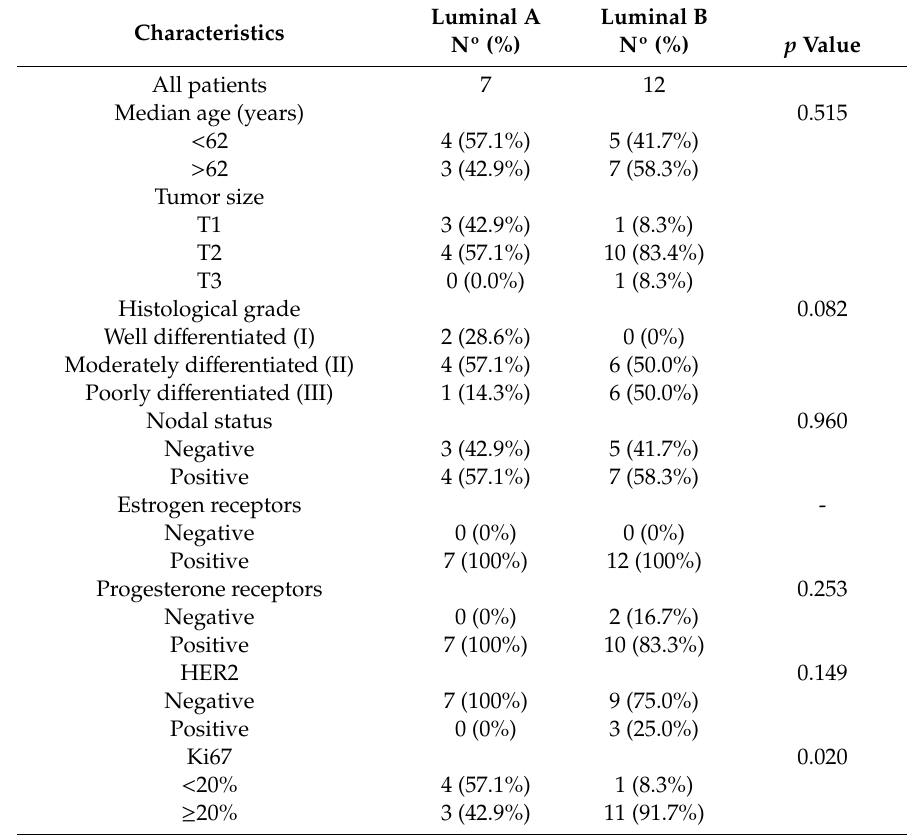
Table 1. Clinicopathological characteristics of the 20 patients with invasive breast carcinoma.